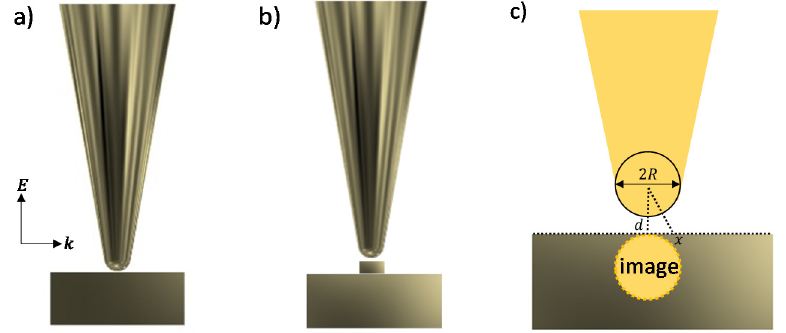
Figure 1. Simulated tip-enhanced Raman spectroscopy (TERS) models consists of ( a ) conical gold tip with various diameters from 2 nm to 160 nm placed on a flat gold film substrate and ( b ) conical gold tip with fixed diameter of 80 nm and a flat gold substrate modified by a 20 nm high gold nanodisc with varying diameter from 5 nm to 120 nm. ( c ) Schematic representation of the image dipole formation from the model shown in Figure 1a. The wavevector propagates along the x -axis and the (cid:1831)(cid:4652)(cid:1318) vector is along the y -axis.